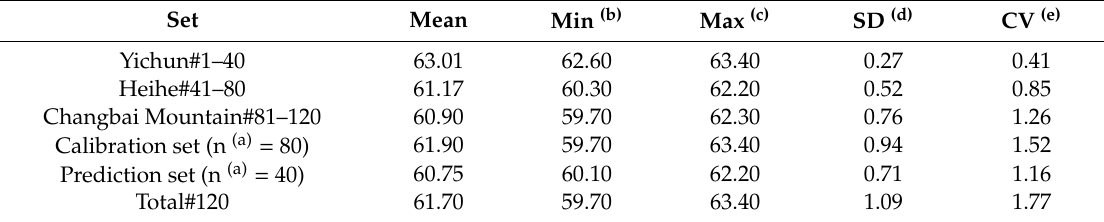
Table 1. Descriptive statistics for lipid contents of Pinus koraiensis seeds as measured by Soxhlet